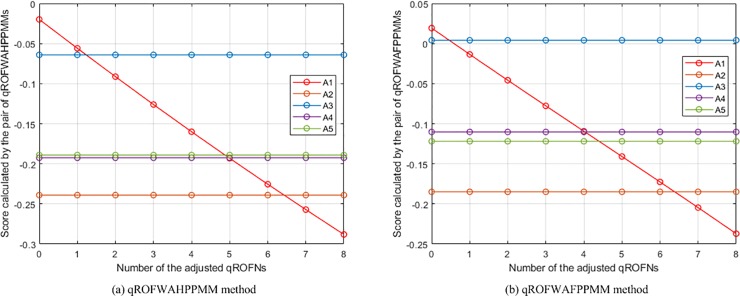
The changes of the places of A1 in the rankings of the WAPPMM method.